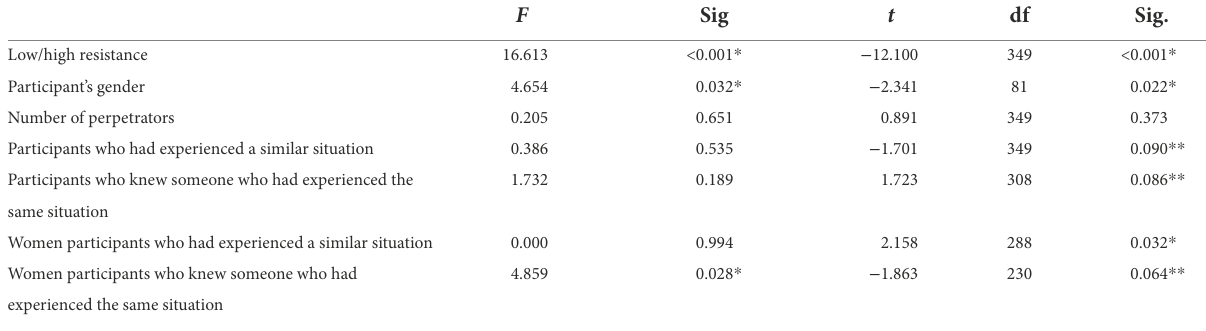
TABLE 3 Resistance levels. Variable Levene’s test for equality of variances